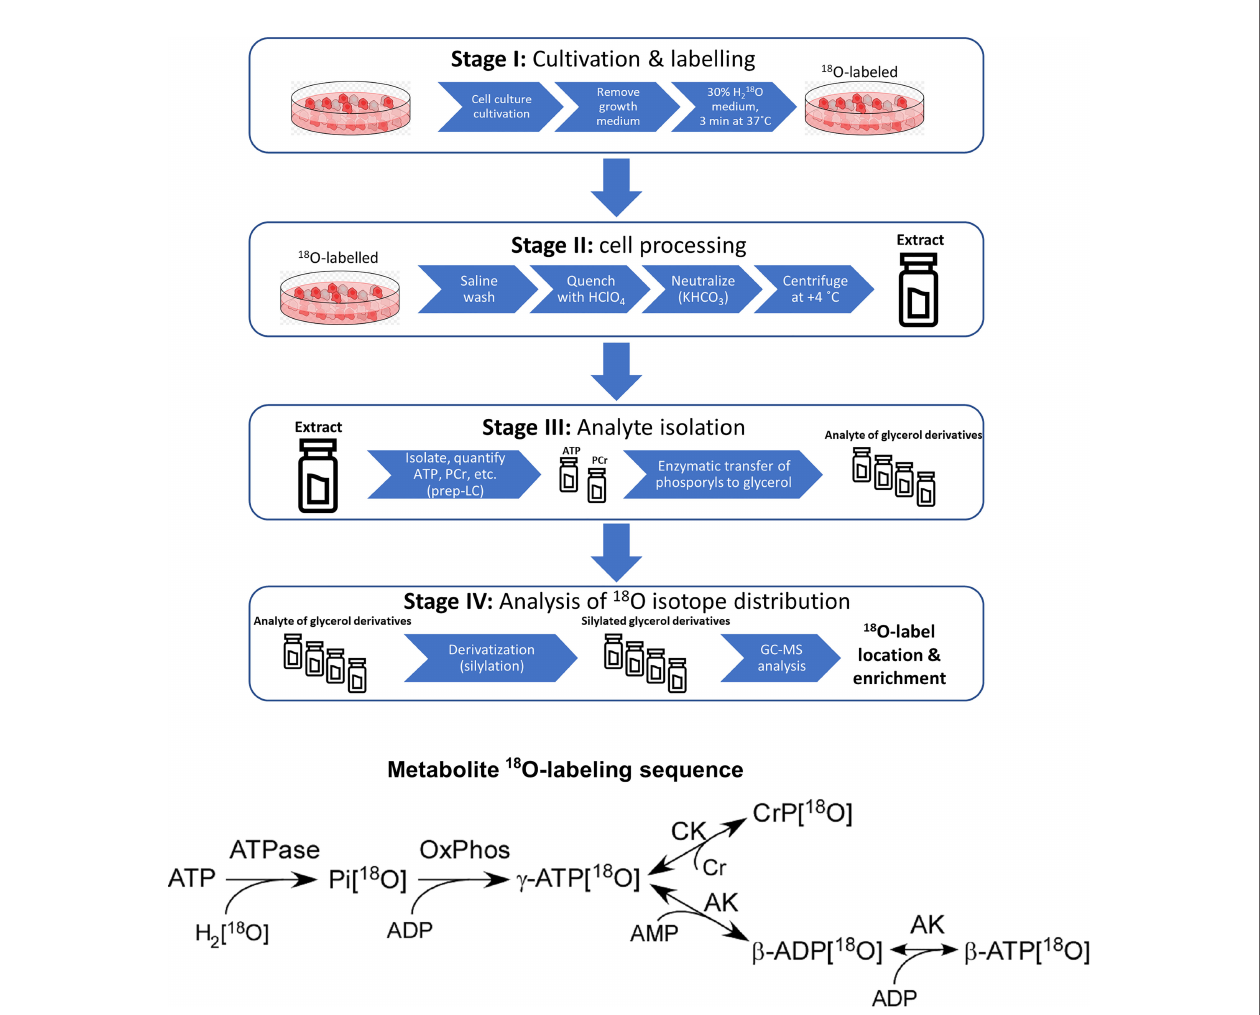
FIGURE 1 | Sample preparation work fl ow for 18 O-labelling based phosphometabolomics and metabolite 18 O-labeling sequence. AK, adenylate kinase; CK, creatine kinase; Cr, creatine, CrP, creatine phosphate; Pi, inorganic phosphate; OxPhos, oxidative phosphorylation; prep-LC, preparative liquid chromatography; GC-MS, gas chromatography-mass